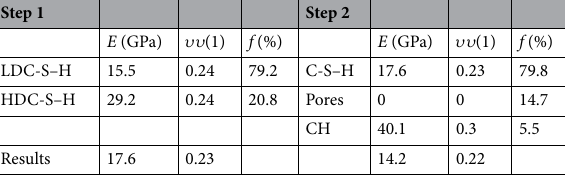
Table 3. The homogenization step 1 and 2 of the multi-scale model.